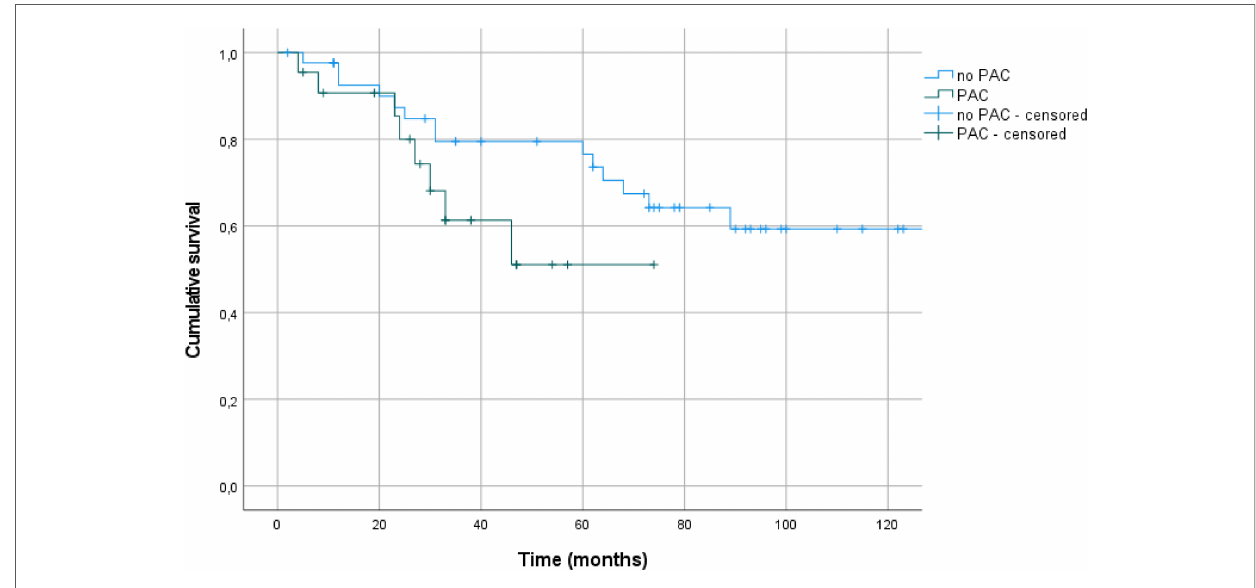
FIGURE 2 Kaplan – Meier plots (+=censored data) for survival of patients with ( n =19) or without ( n =46) premature atrial contractions